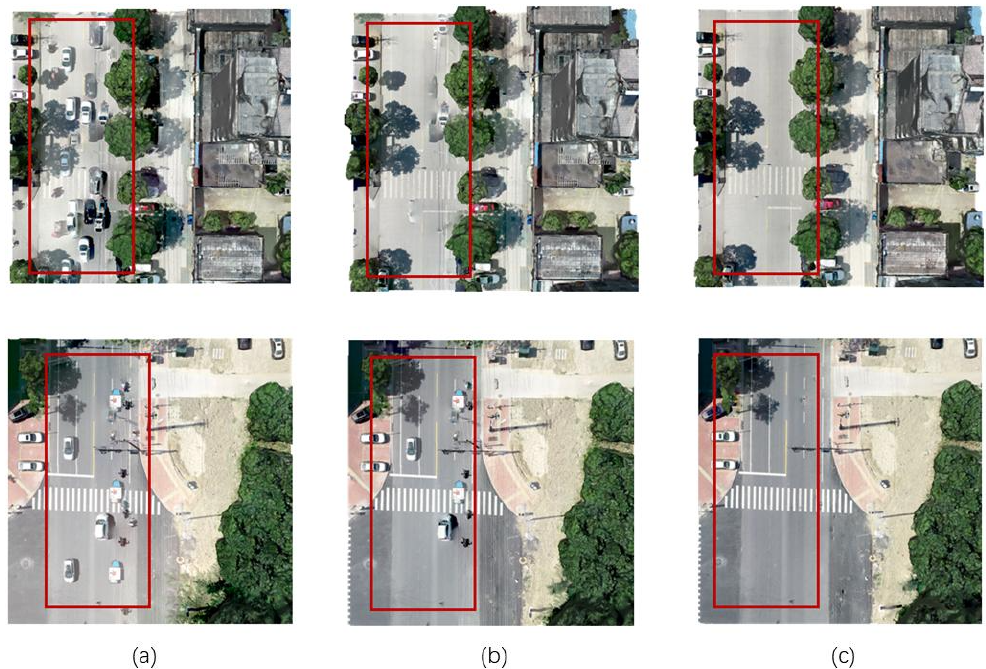
Figure 5. Comparison of the results of the three methods on dataset TJH-0078: ( a ) results of experi- ments without image consistency detection; ( b ) results of the method of mvs texturing; and ( c ) results of our